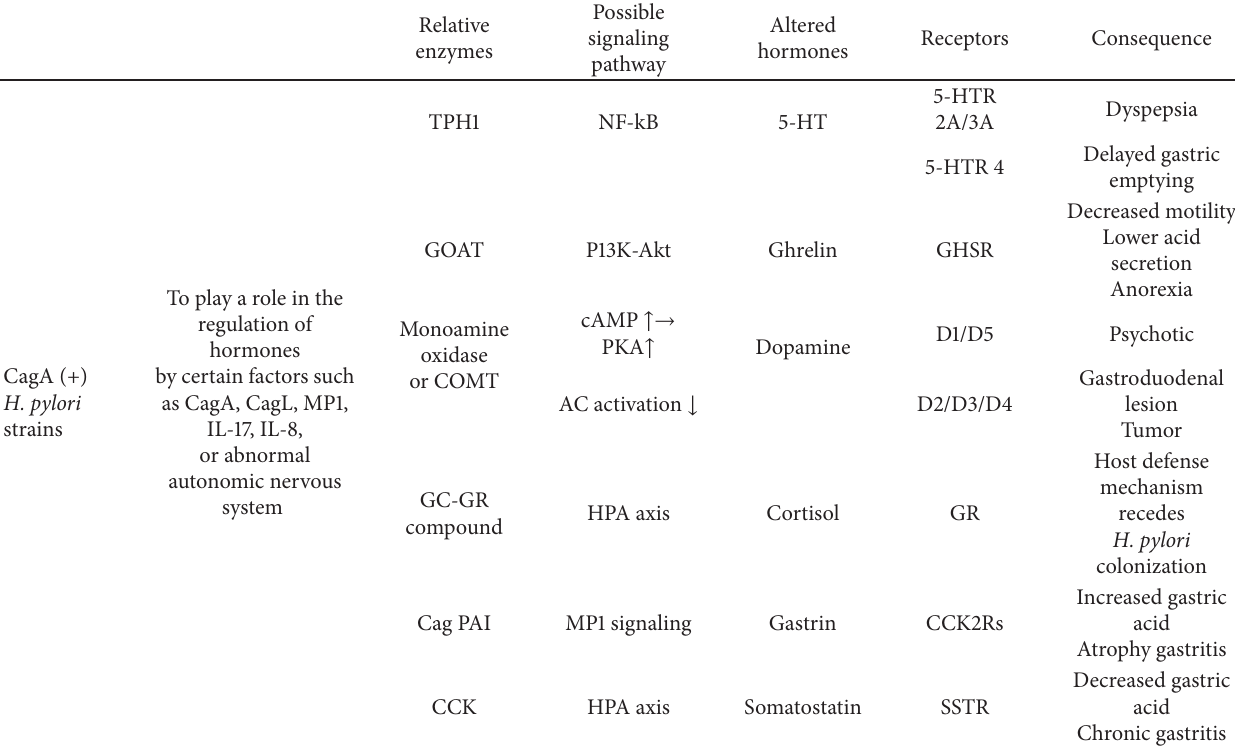
Table 1: Possible relationship between H. pylori and several